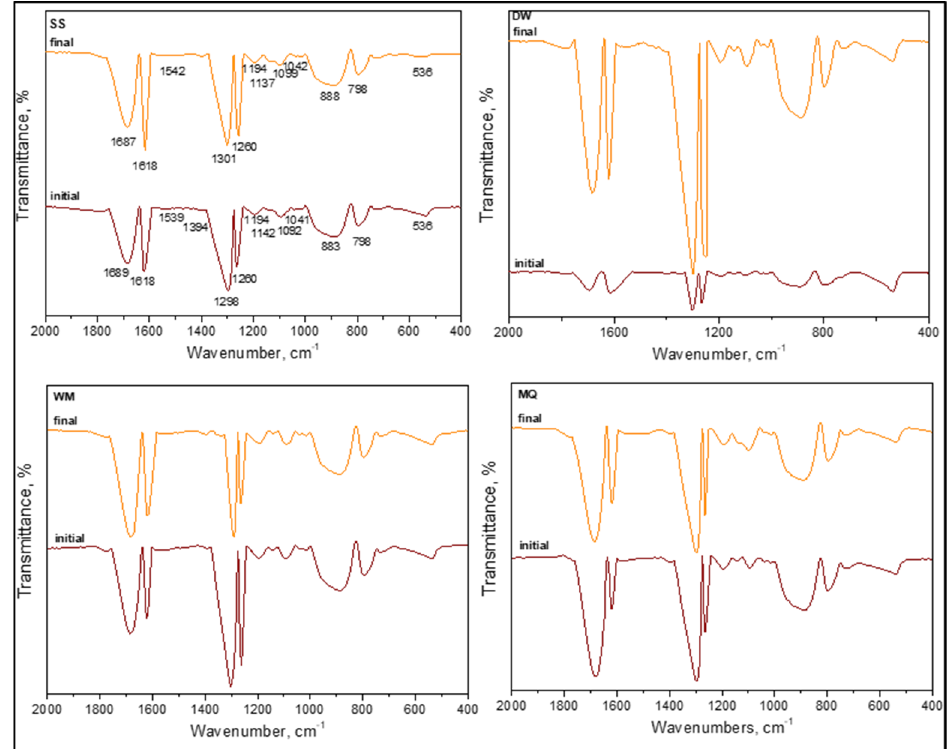
Figure 11. FTIR transmittance spectra of E. coli and LF under various conditions in the absence of NOM compounds prior to (initial) and following (final) SPCI.